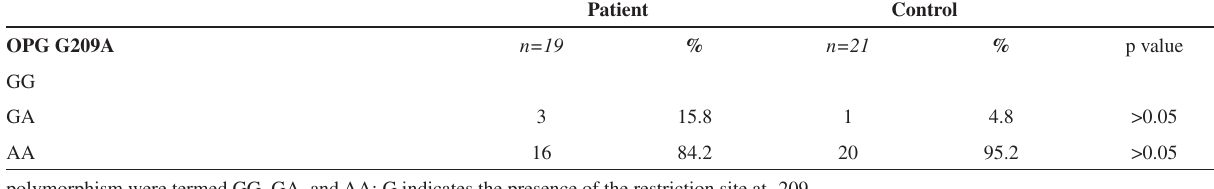
Table 4 - Distribution of OPG genes G209A and T245G as well as IL-6 gene G-174C polymorphisms in the groups Patient